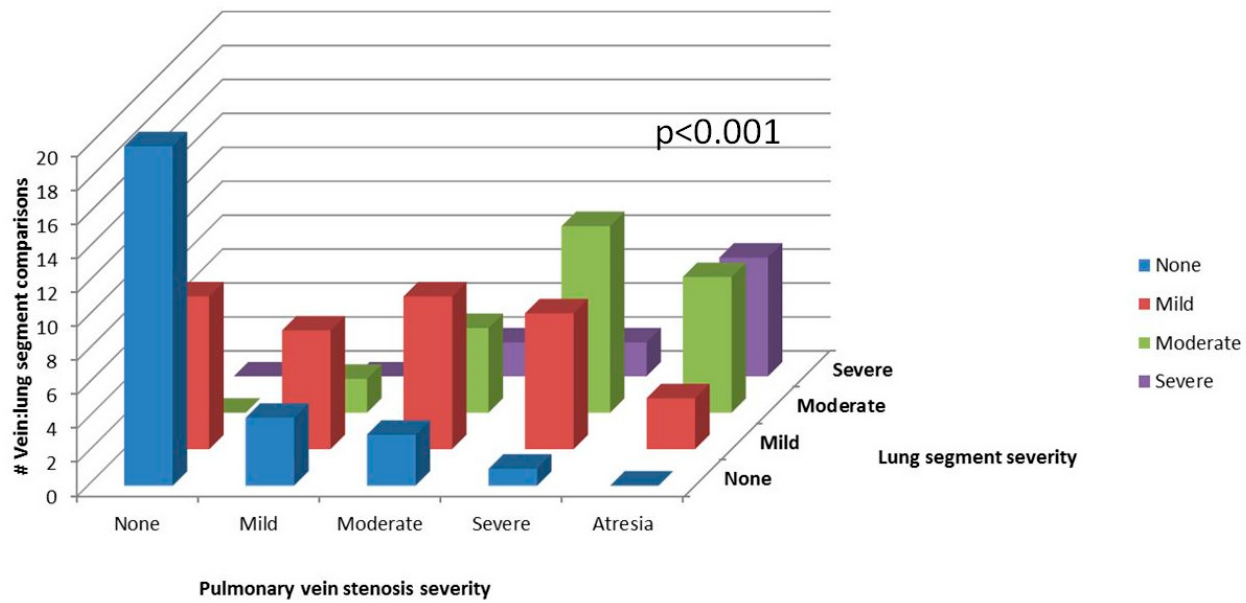
Figure 2. Relationship between pulmonary vein stenosis severity and associated lung segment severity (198 vein and lung segment comparisons). Table 3. Individual pulmonary vein and lung segment characteristics by CT (N = 199 veins; 202 lung segments). Data expressed as N (%) or median (IQR) *.